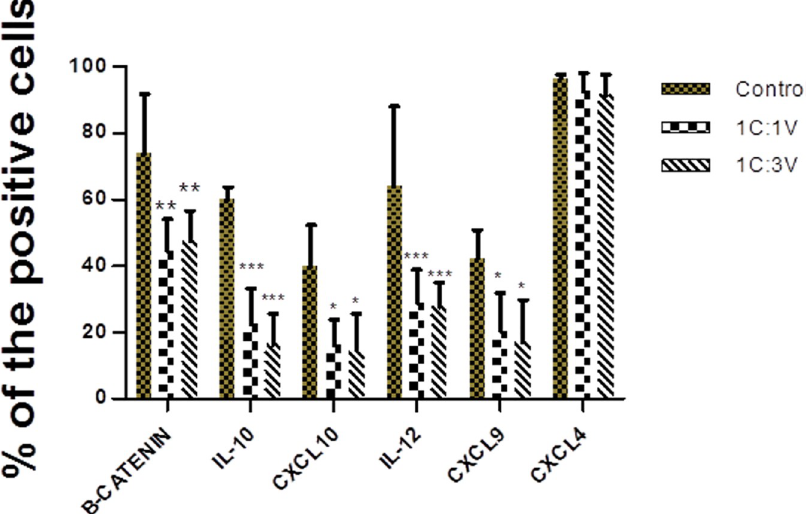
Fig 11. Expression of cytokines and chemokines in pre-treated CVMSCs with MDA-MB231 through a transwell membrane. Two-way ANOVA analyzed the two treated groups; 1:1 and 1:3 and each group was compared to the control. The control is CVMSCs without any treatment. C is MDA-MB231, V is CVMSCs. CVMSCs = human placental chorionic villi derived